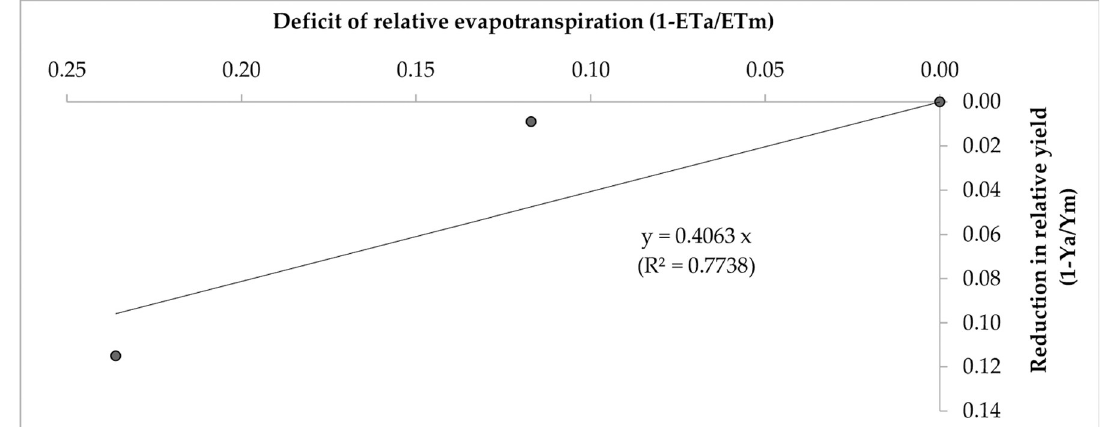
Fig 4. Relationship between relative yield deficit and relative evapotranspiration deficit (average of 3 cropping seasons).